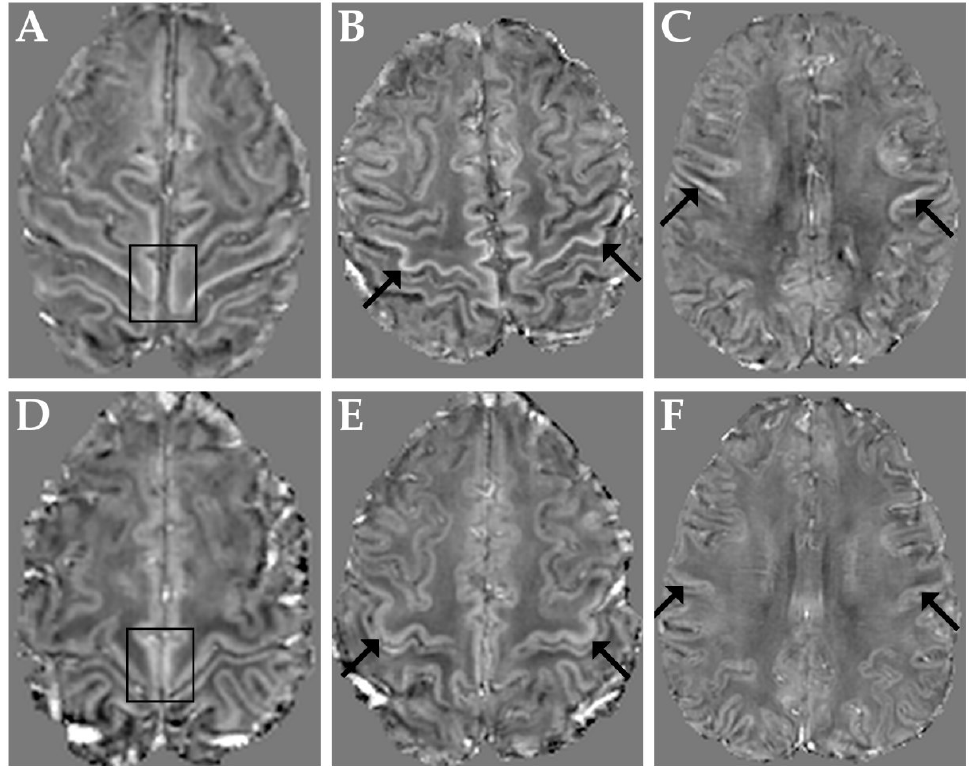
Figure 1. Top row: representative QSM images obtained in three ALS patients with M1 χ increase in the paracentral lobules ( A ), in both hand-knob areas ( B ) and in the orofacial regions ( C ). Bottom row: QSM images in a representative control subject at the level of the paracentral lobules ( D ), hand-knob ( E ) and orofacial regions ( F ). Arrows and boxes indicate corresponding regions in patients and control subject.